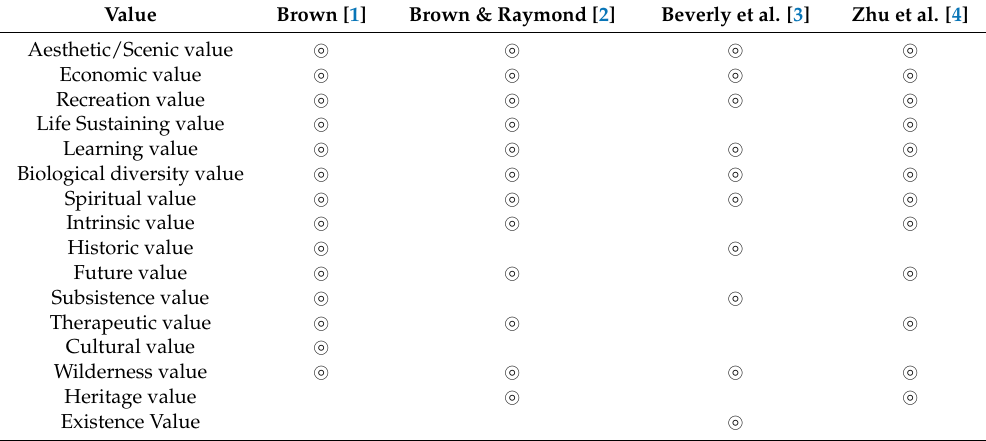
Table 1. The measurement of place value in natural